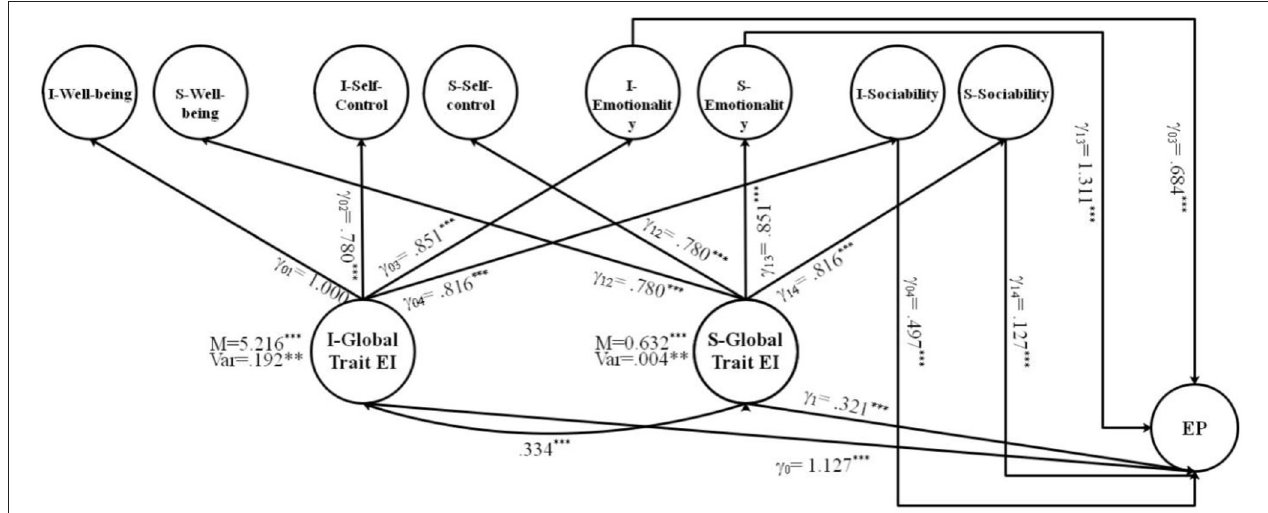
FIGURE 5 | A full FCM of TEI with the a latent predictor variable (EP), incorporating significant paths from EP to the subdomains. I, intercept; S, slope; TEI, trait emotional intelligence; WB, well-being; SC, self-control; EM, emotionality; SO, sociability; EP, emotion perception; M, mean; Var, variance; ε = error; γ = factor loading [ χ 2 (df) = 261.614 (97), p < 0.001; CFI/TLI = 0.982/0.973; RMSEA = 0.053; SRMR = 0.057]; *** p < 0.001 ; ** p <